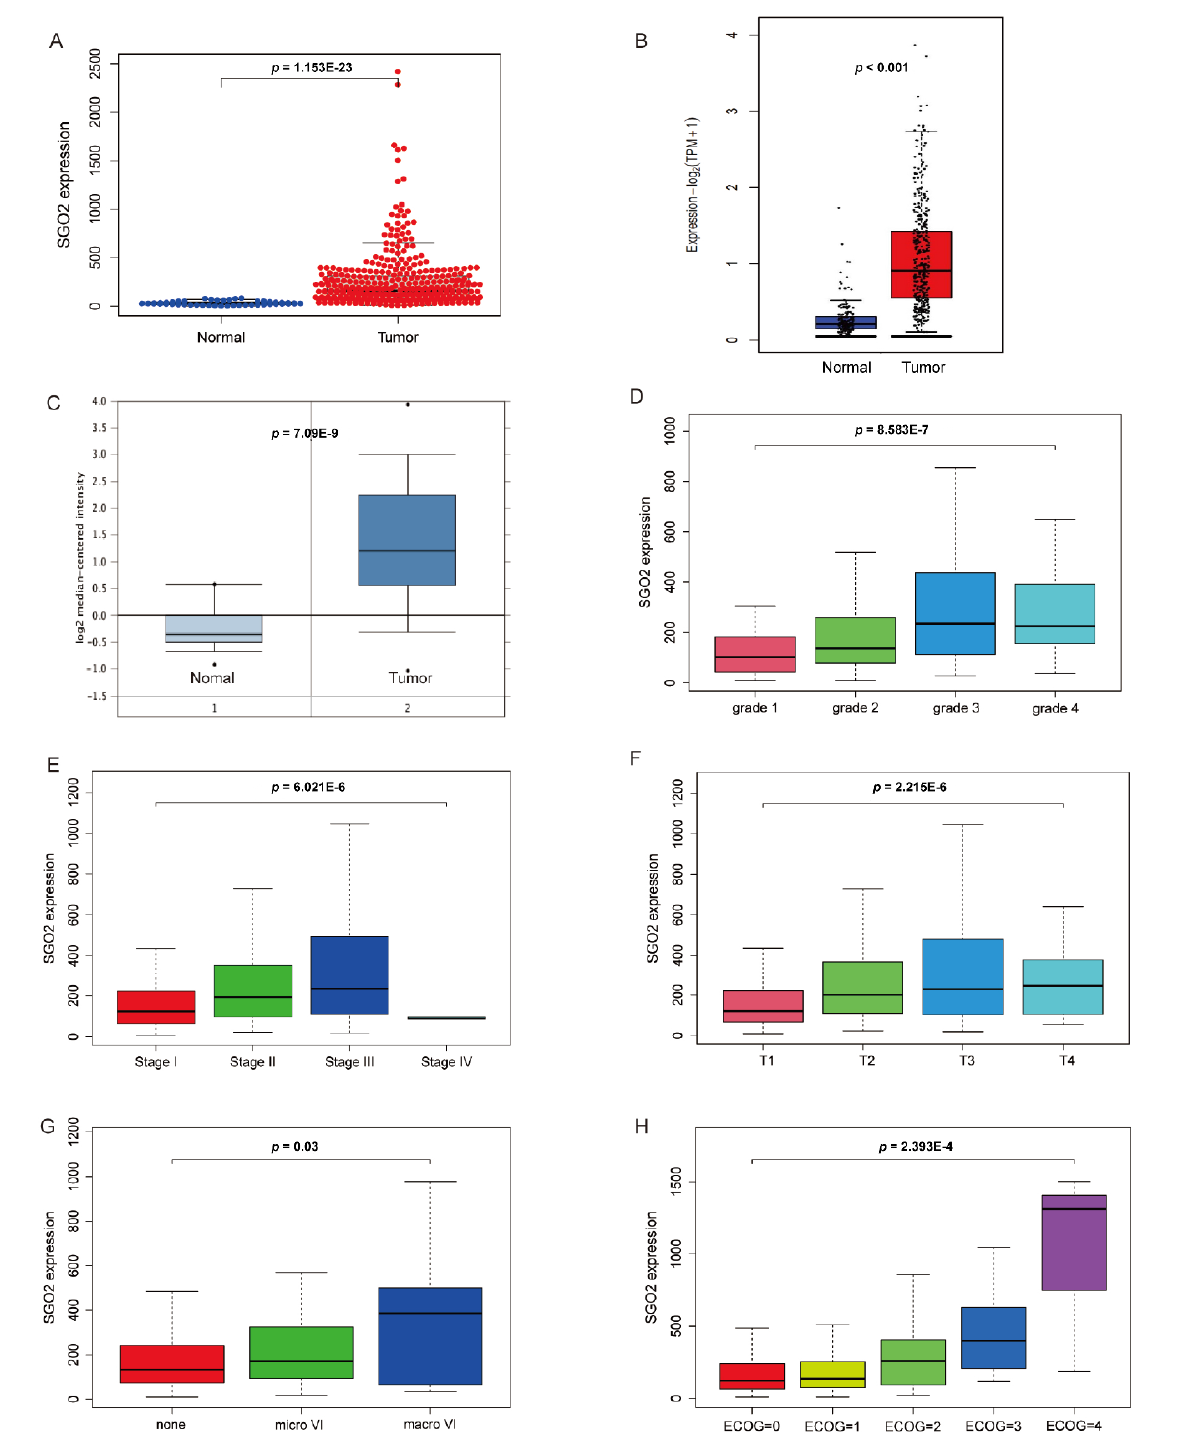
Figure 1. The expression of SGO2 and its association with the clinicopathological features based on the TCGA, Oncomine, and GEPIA2 data. ( A ) Comparison of the SGO2 expression between nontumor samples and HCC samples in the TCGA database. Validation of the SGO2 expression level by the GEPIA2 ( B ) and Oncomine ( C ) databases. The expression of SGO2 in the clinicopathological parameters, including tumor grade ( D ), pathological stage ( E ), T stage ( F ), vascular invasion ( G ), and ECOG score ( H ). SGO2, shugoshin 2; TCGA, The Cancer Genome Atlas; GEPIA2, Gene Expression Profiling Interactive Analysis 2; HCC, hepatocellular carcinoma; ECOG, Eastern Cancer Oncology Group.